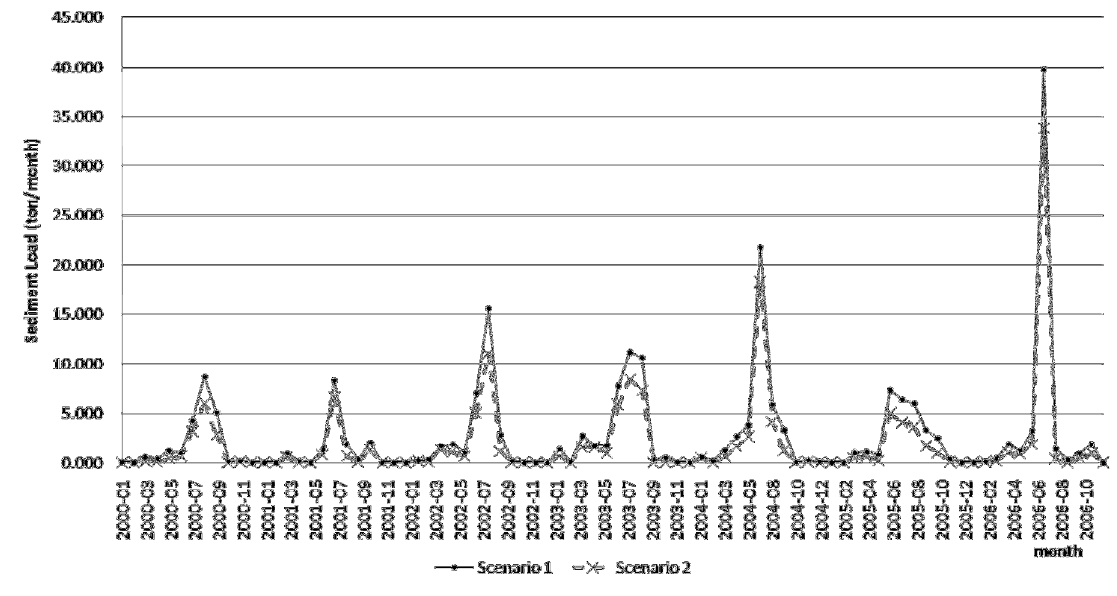
Figure 15. Comparison of Simulated Monthly Sediment for Scenarios 1 and 2.